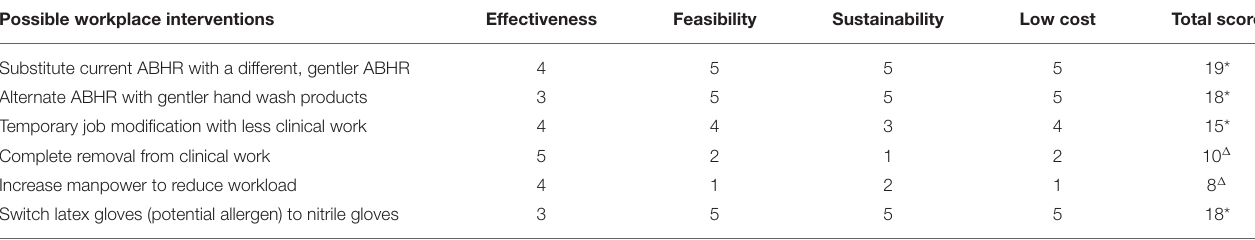
TABLE 1 | Prioritisation matrix for possible workplace interventions. Possible workplace interventions Effectiveness Feasibility